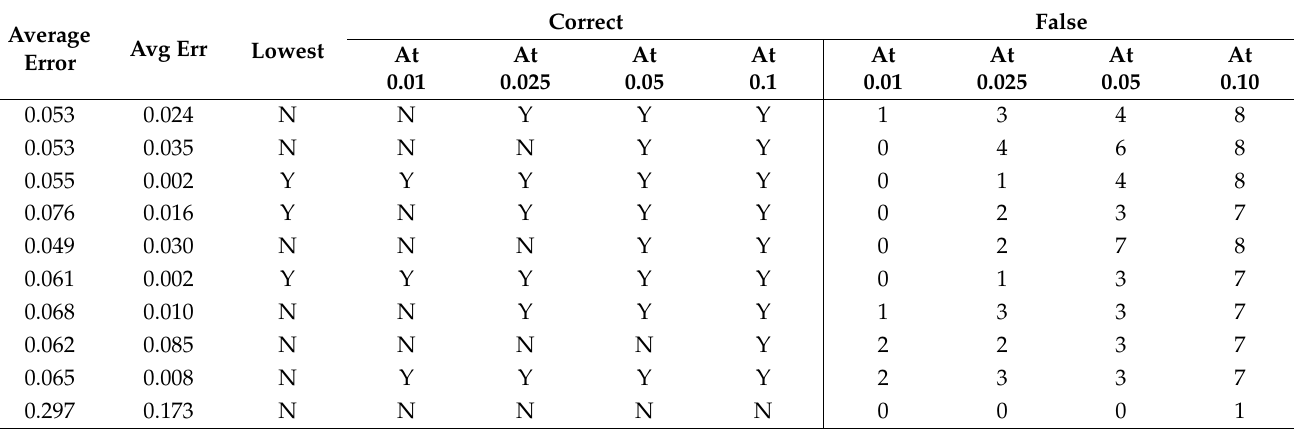
Table 3. Set 1, trials 21–30 summary data (actual PR value).